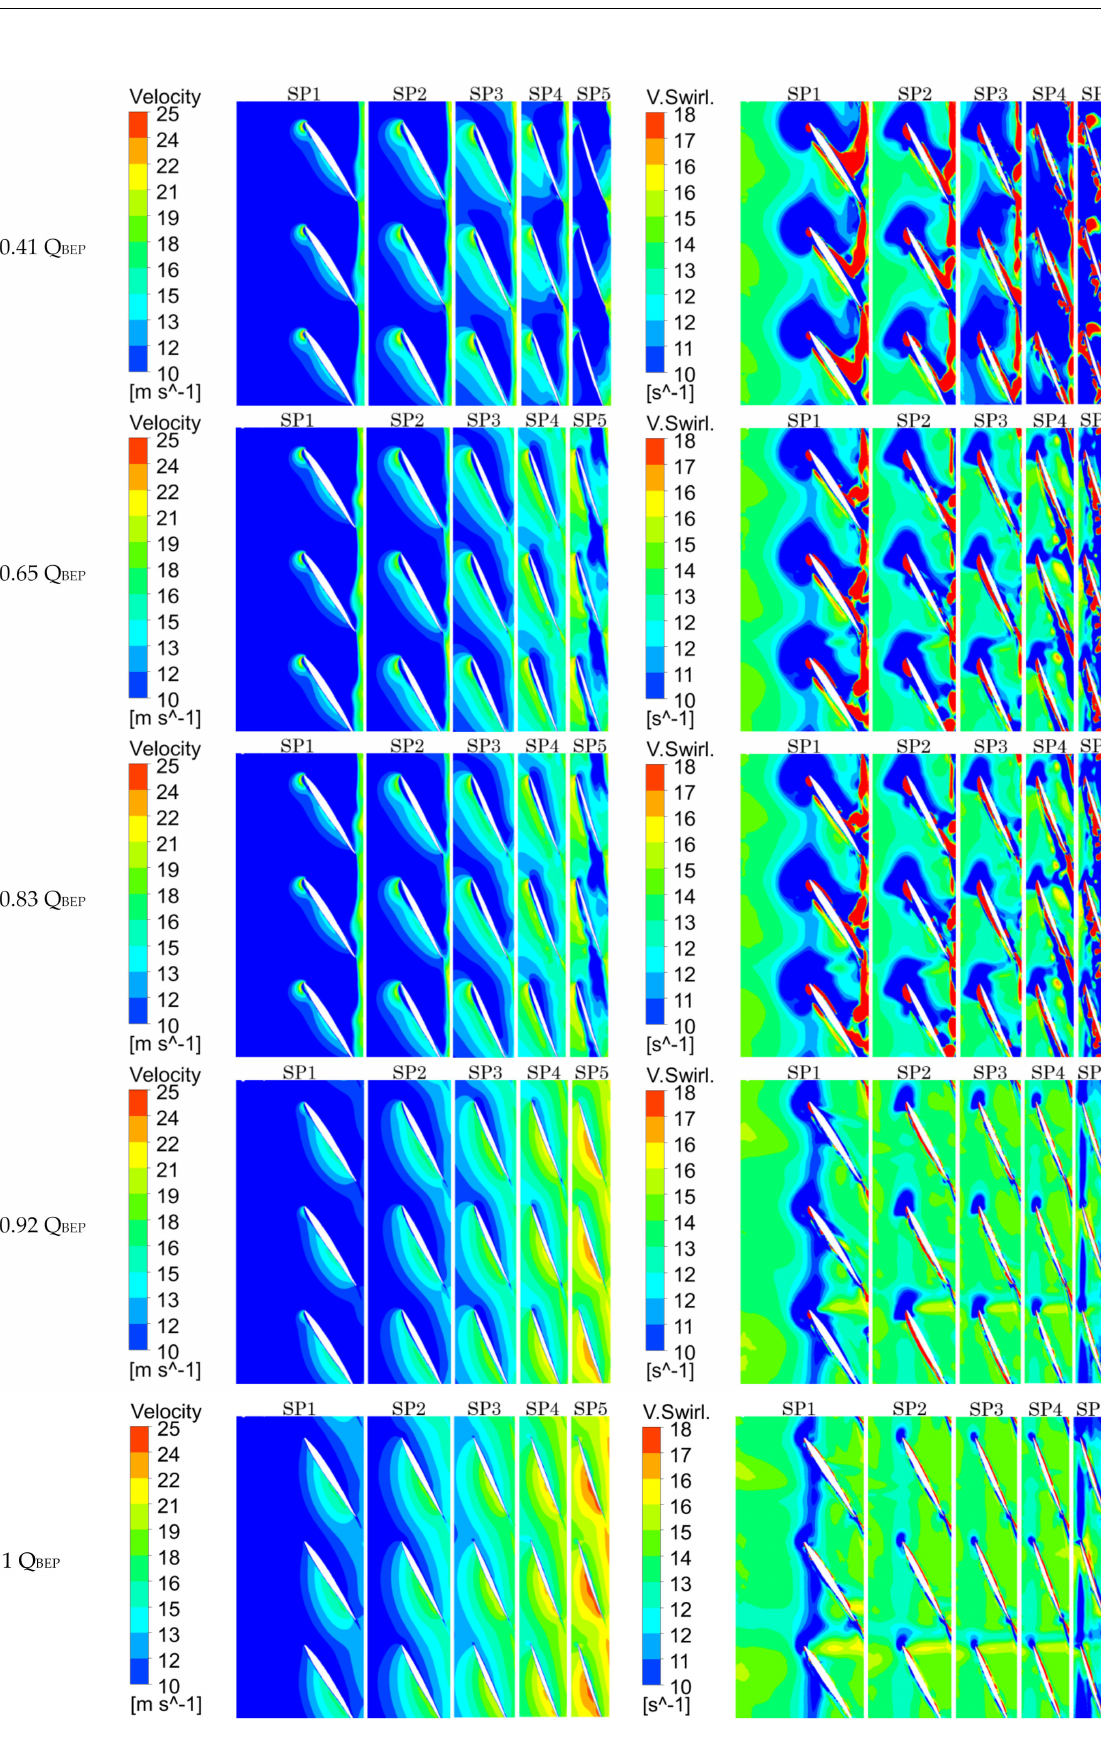
Figure 8. Contours of flow velocity and vorticity within the runner inter-blade flow zone for different flow